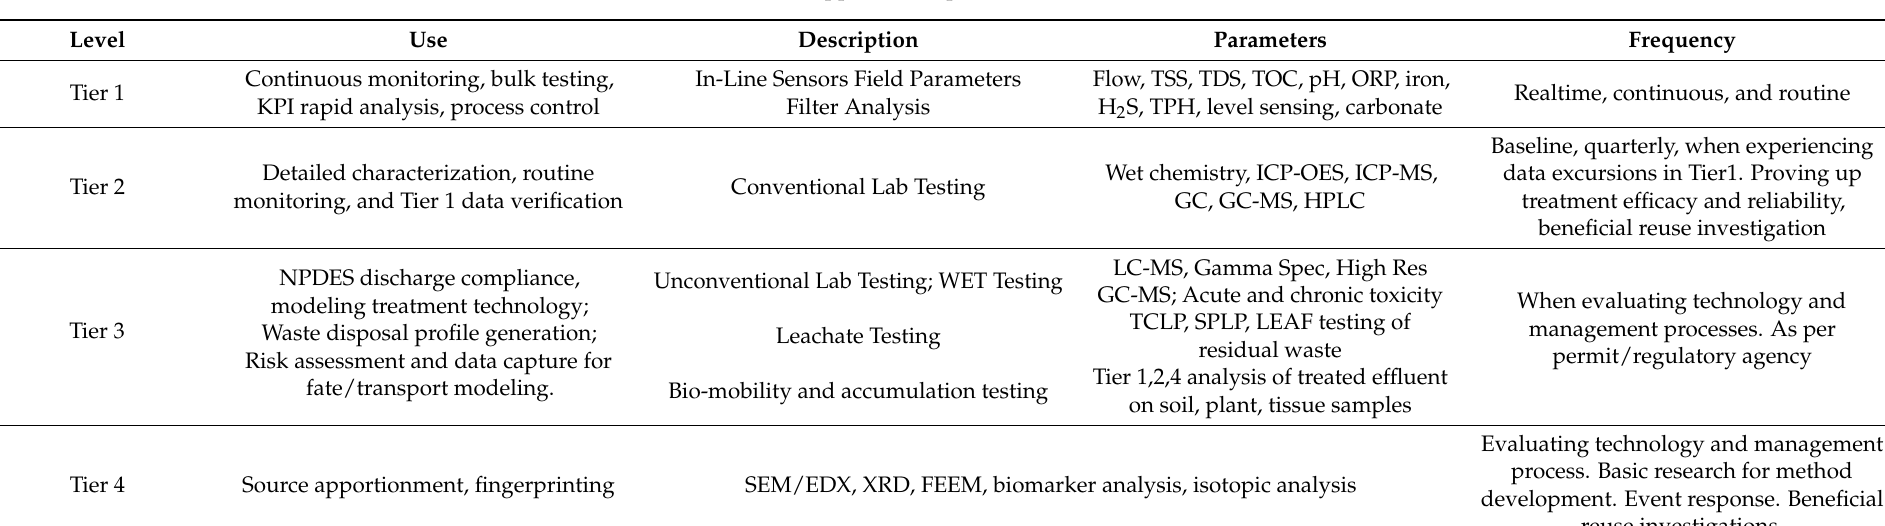
Table 2. Multi-tiered approach for produced water